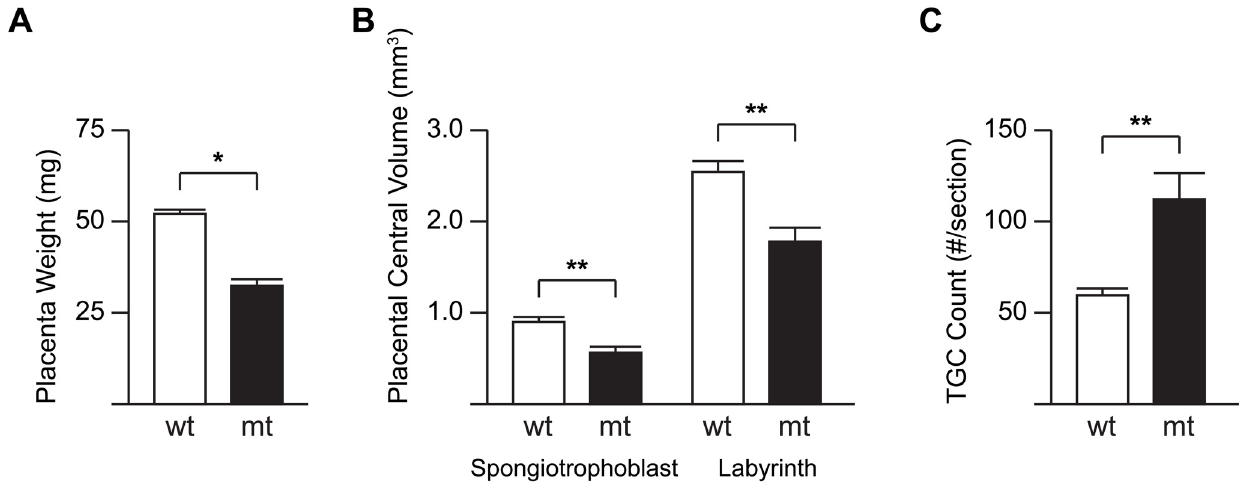
Fig 3. Phenotypic comparison of wild-type (wt) and DNMT1o-deficient (mt) placentas at E12.5. (A) Measurements of wet placenta weight, (B) Spongiotrophoblast and Labyrinth central volume, and (C) the number of TGCs per slide of a cohort of wt and mt placentas are displayed as open and filled bars respectively. Data are plotted as mean +SEM. * (P < 0.05) and ** (P < 0.005) denote significant differences between wt and mt averages by the Rank-sum